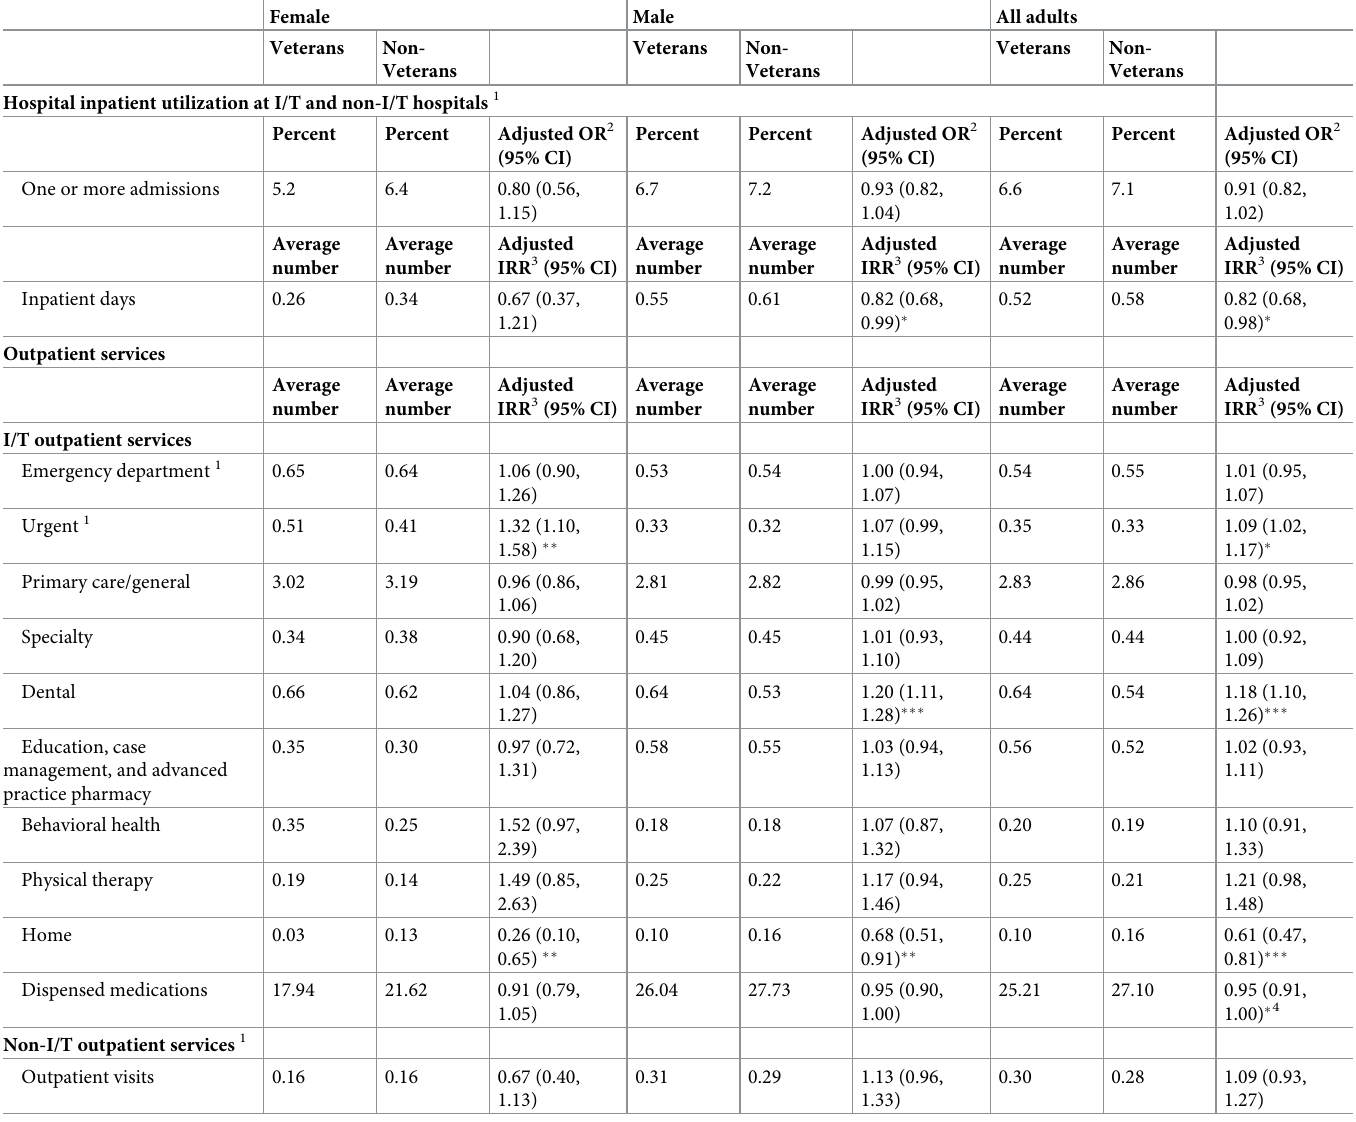
Table 3. Hospital inpatient and outpatient service utilization among American Indian/Alaska Native veterans and non-veterans, by sex, at IHS and Tribal (I/T) health facilities and non-I/T facilities. Fiscal year